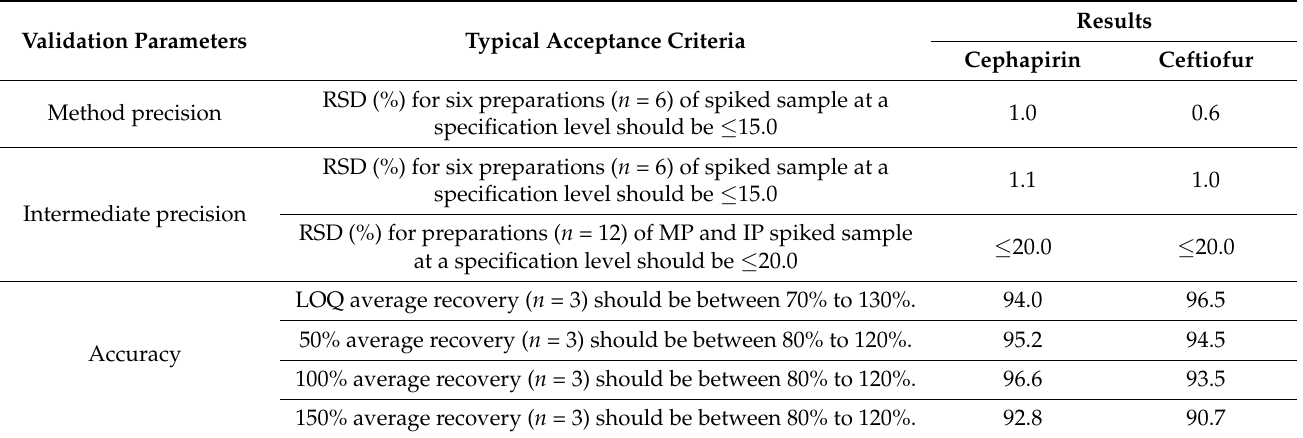
Table 2. Method validation results